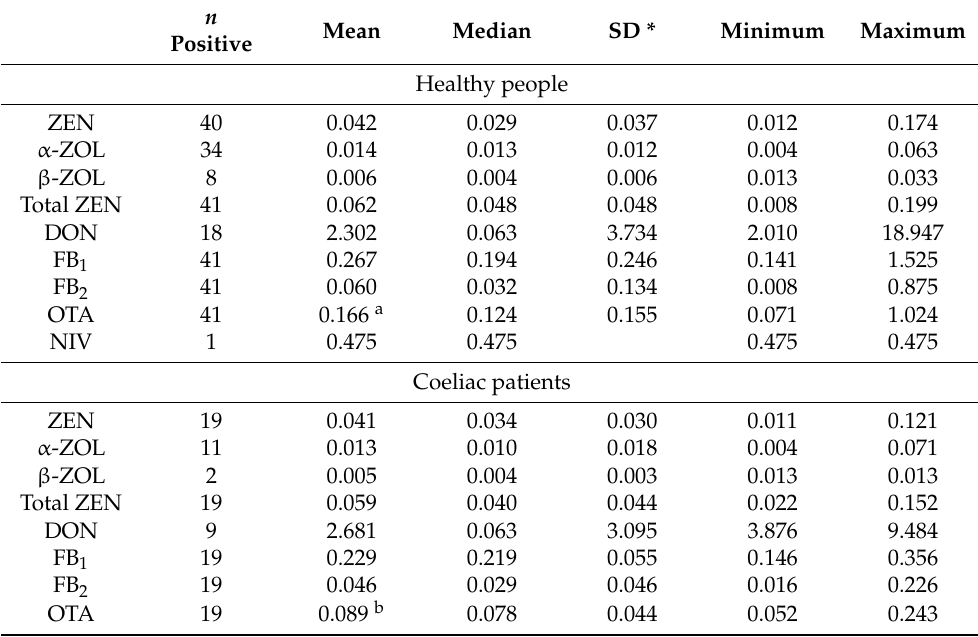
Table 2. Concentration of mycotoxins (ng/mL) in the urine samples of healthy people and coeliac patients. n Mean Median SD * Minimum Maximum Positive Healthy people ZEN 40